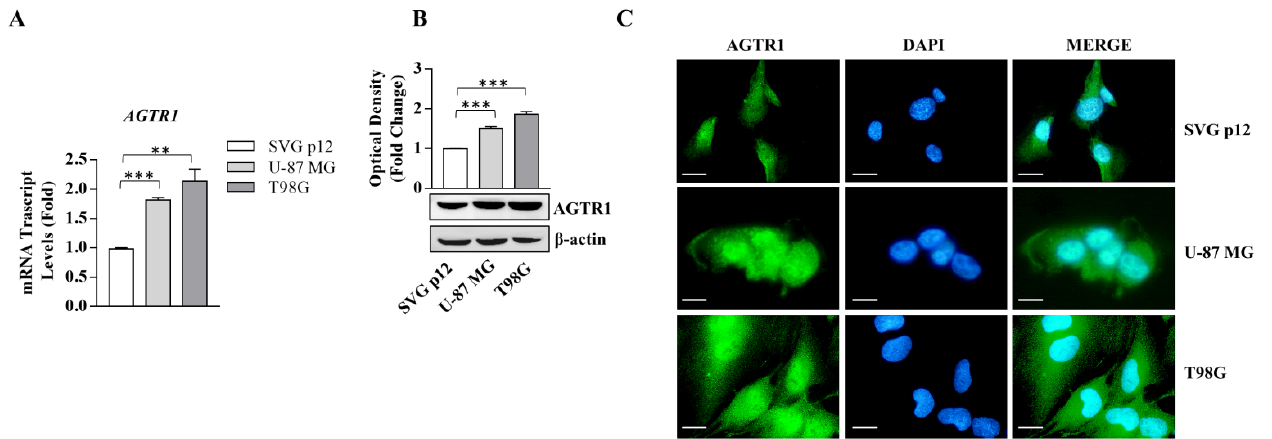
Figure 1. AGTR1 expression in SVG p12 normal glial cells and U-87 MG and T98G glioblastoma cells. ( A ) Real-time RT-PCR for AGTR1 in SVG p12, U-87 MG, and T98G cells; mRNA is shown relative to SVG p12 normal glial cells. ( B ) Immunoblotting showing AGTR1 protein expression. β-actin was used as a loading control. The histograms represent the mean average ± SD of three separate experiments in which band intensities were evaluated in terms of optical density arbitrary unit and expressed as fold change over SVG12 for U-87 MG and T98G. ( C ) Immunofluorescence of AGTR1 in SVG p12, U-87 MG, and T98G cells. DAPI staining for nuclear detection. Scale bars = 5 µm. Original magnification, ×100. Data are expressed as means ± SD of three different experiments, each performed in triplicate. ** p < 0.01; *** p < 0.001.